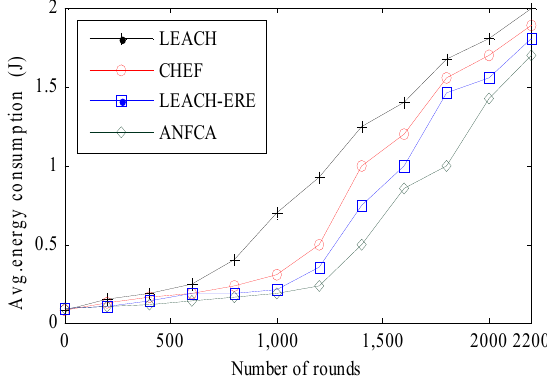
Figure 10. Avgerage energy consumed by nodes over the rounds.